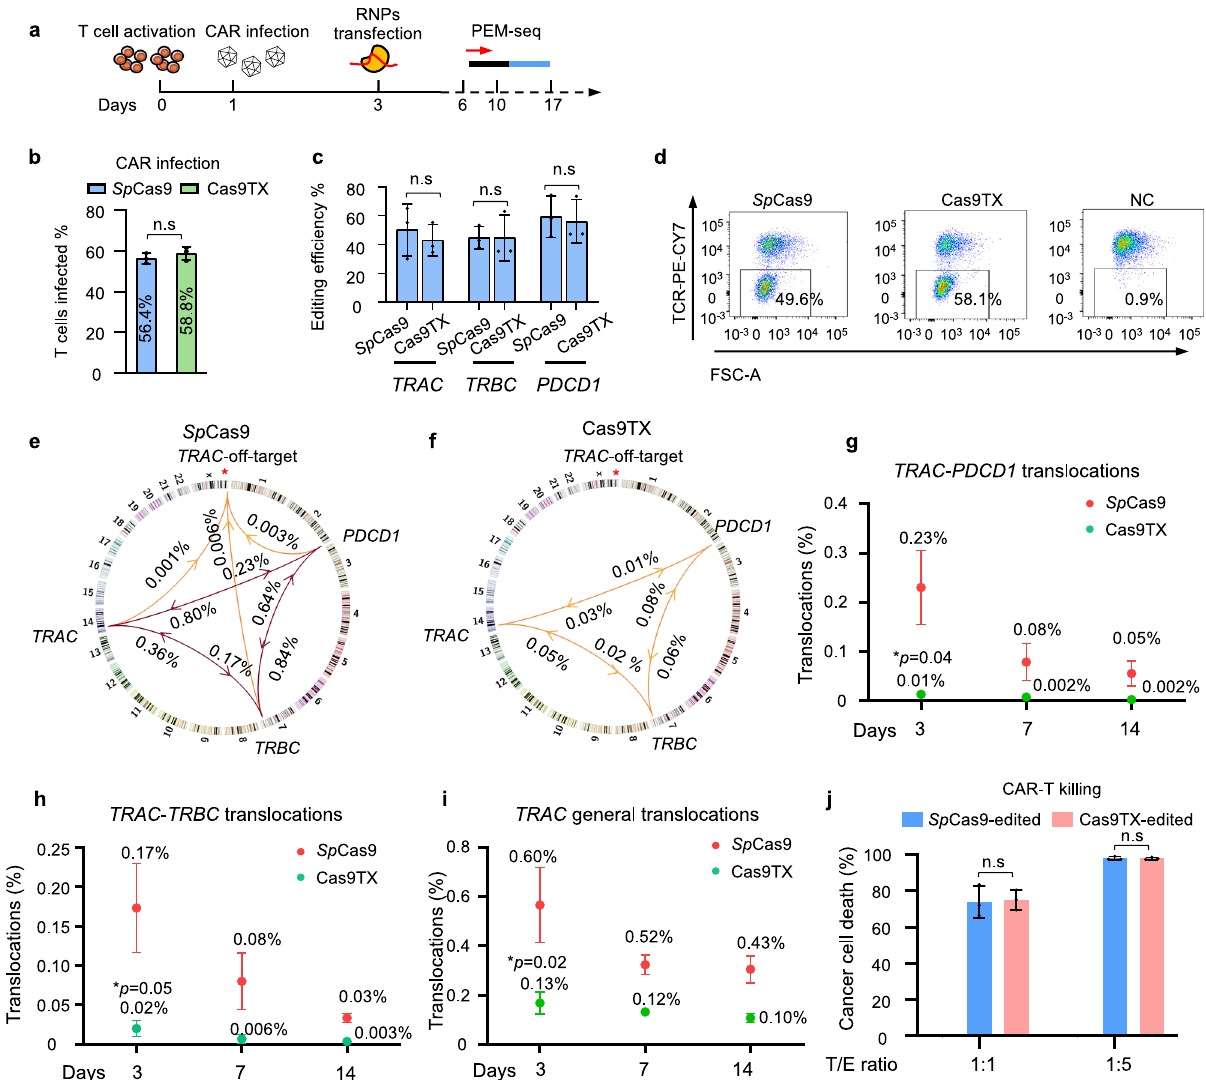
Fig. 7 Elimination of chromosomal translocations by Cas9TX in CAR T cells. a Schematics for the manufacturing of CAR-T cells by Sp Cas9 or Cas9TX RNPs. Human T cells obtained from human cord blood were activated for 3 days by anti-CD3/CD28, infected by a lentivirus carrying anti-CD19 scFv, and transfected with Sp Cas9/Cas9TX RNPs. CAR-T killing assays were performed at 3-days post-transfection, and translocations among TRAC , TRBC , and PDCD1 were analyzed by PEM-seq at 3-, 7-, and 14-days post-transfection. See methods for more details. b Percentages of T cells infected by the lentivirus carrying CAR-CFP detected by FACS. Paired two-tailed t -test, mean ± SD from three biological replicates; n.s, no signi fi cance. c Editing ef fi ciency at the TRAC , TRBC , and PDCD1 genes at 3-days post-transfection detected by PEM-seq. Paired two-tailed t -test, mean ± SD from three biological replicates; n.s, no signi fi cance. d Representative fl ow cytometry results indicating TCR expression levels at 3-days post-transfection. NC is the negative control without RNP editing. e , f Circos plots indicating translocations among TRAC , TRBC , PDCD1 , and TRAC off-targets by Sp Cas9 ( e ) or Cas9TX ( f ) at 3 days after RNP transfection detected by PEM-seq. Mean values for three biological replicates are indicated. Red asterisks indicate the identi fi ed TRAC off-target site, depicted as described in the legend to Fig. 1c. g – i The ratios of Sp Cas9- or Cas9TX-induced translocations of TRAC - PDCD1 ( g ), TRAC - TRBC ( h ), and TRAC general translocations ( i ) cloned from TRAC by PEM-seq at 3-, 7-, and 14-days post-transfection. Mean values for three biological replicates are indicated. Mean± SD, paired two-tailed t -test, * p < 0.05, ** p < 0.01. j The killing capacities of Sp Cas9- and Cas9TX-editing CAR-T cells were evaluated by CD19 + K562 killing assay. T indicates target cells and E indicates effector cells. Mean± SD from three biological replicates, two-tailed t -test, n.s means no signi fi